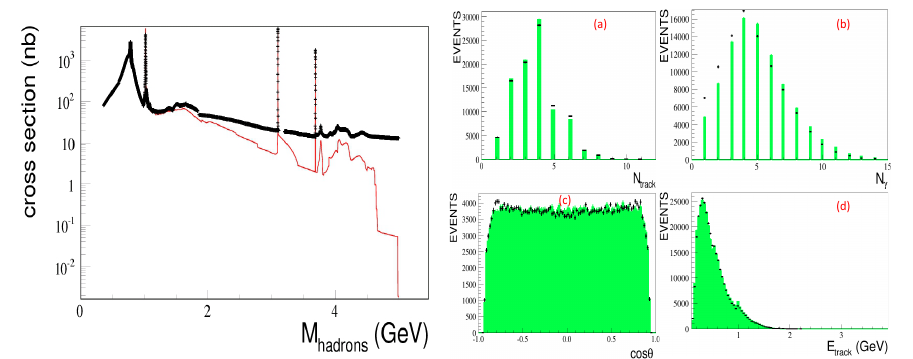
Figure 5. Left: the Born cross section of e + e − → hadrons below 5 GeV. The black points are the total cross section measured in inclusive method, the red points are the sum of the measured exclusive cross sections. Right: Comparison between data and MC in scheme A at 3.65 GeV. (a) multiplicity of charged track; (b) multiplicity of photon; (c) polar angle cos θ ; (d) momentum of charged